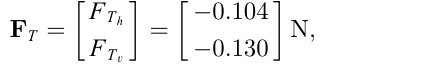
bent in the second phase. The slipping is visible in the orbit plot indicated by abrupt movements downwards and slightly in horizontal direction against the plectrum move- ment. When the string has reached the tip of the plectrum